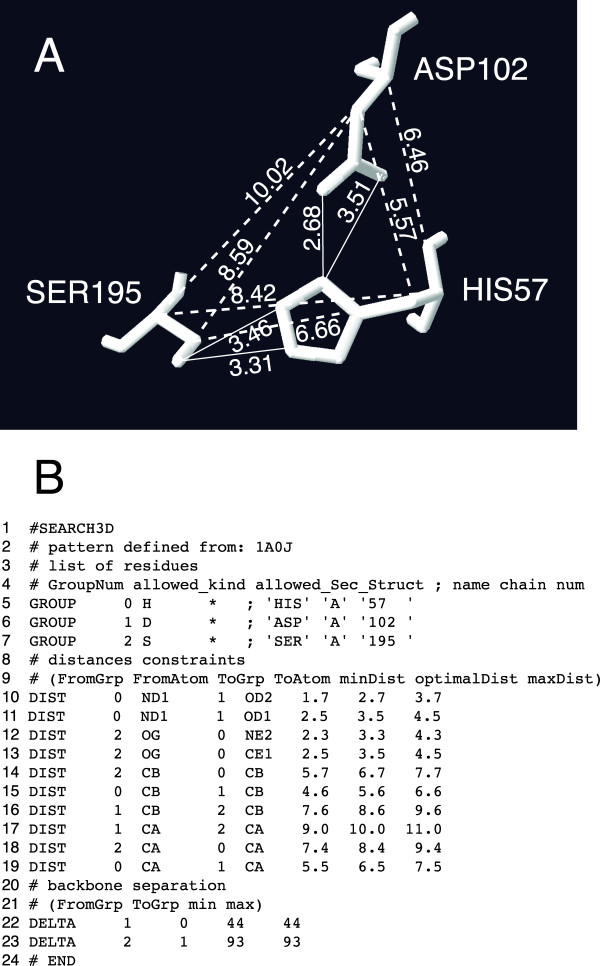
Motif definition and specification.A) Structural motif involving residues His57, Asp102 and Ser195 of 1a0j, and interactively measured distances, as rendered by Swiss-PdbViewer (with legibility enhancements). B) Textual representation of the motif specification corresponding to the image in Figure 1 (the secondary structure constraints have subsequently been set to “*” using a text editor).